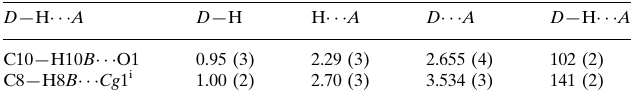
Hydrogen-bond geometry (A˚ , (cid:2)